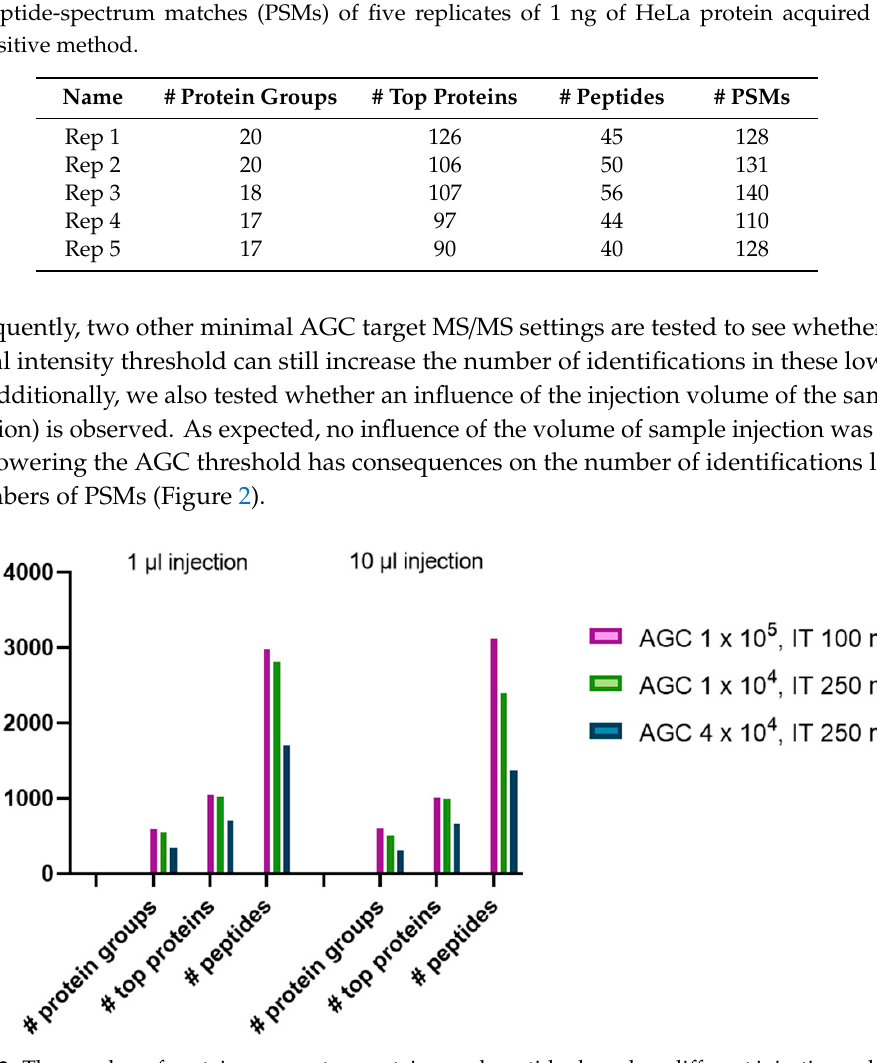
Figure 2. The number of protein groups, top proteins, and peptides based on different injection volumes (1 or 10 µL) and automated gain control (AGC) and injection time (IT) settings.